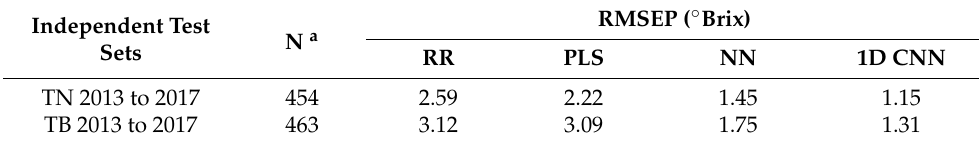
Table 6. RMSEP values for sugar content when independent test sets with different varieties/vintages are applied in the previously established models to evaluate and compare their generalization